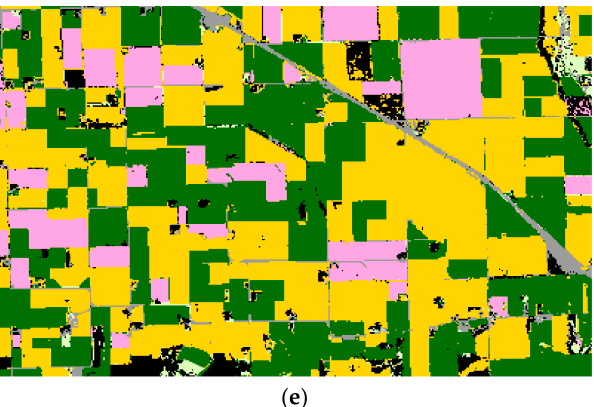
Figure 9. South Dakota classification results. Green = soybeans; yellow = corn; gray = developed/open space; pale green = grass/pasture; magenta = alfalfa; black = background (CDL classes covering ≤ 2% of the study area). ( a ) TI. ( b ) PCA. ( c ) LE-SAM-R. ( d ) LE-DTW. ( e ) STS.